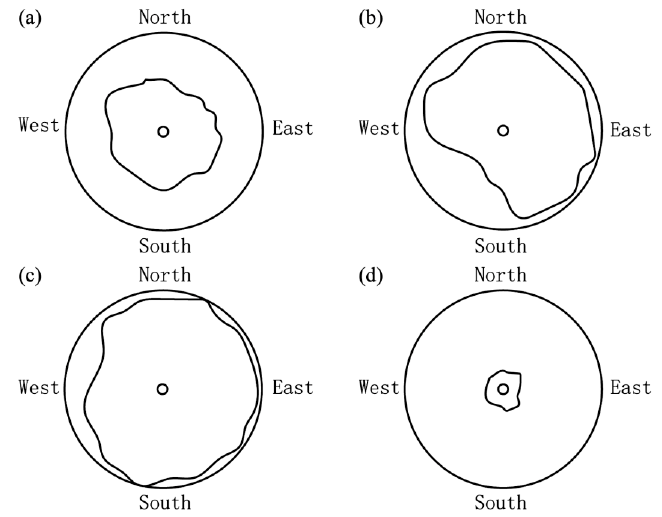
Figure 10. Plane distribution of trunk grouting veins. ( a ) The first trunk grouting vein, ( b ) the second trunk grouting vein, ( c ) the third trunk grouting vein, and ( d ) slurry bubble.